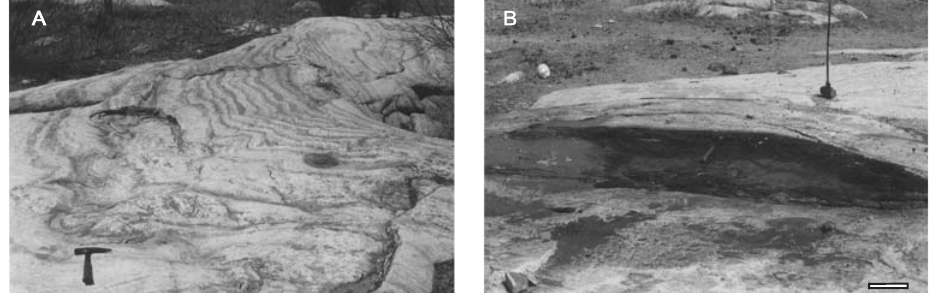
Fig. 2 –A. Marble succession presenting cyclic graphite-rich layers (Pedra de Cal section). B.Amphibolite layer interlayered with marbles in the Pedra de Cal Section. The white rectangle is 40 cm